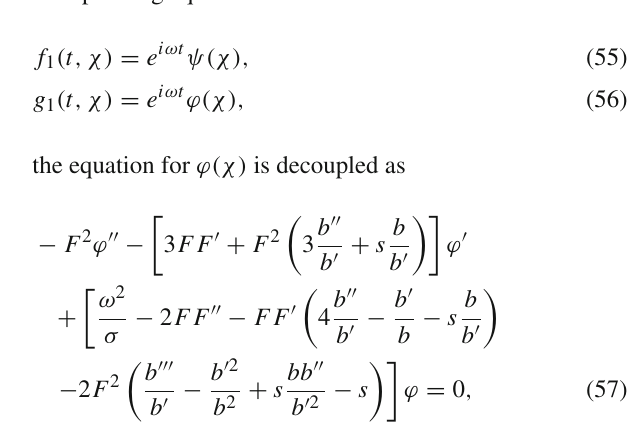
Fig. 6 Plot of effective potential V (χ) for H 3 . [ L = 0 (blue), L = 1 (red) for timelike.] (i) RN black-hole type solution: K = 1, Q = 1, R 0 = 1, L null = 1. The central singularity is not accessible. For the high energy level, the geodesic motion can reach the asymptotic infin-